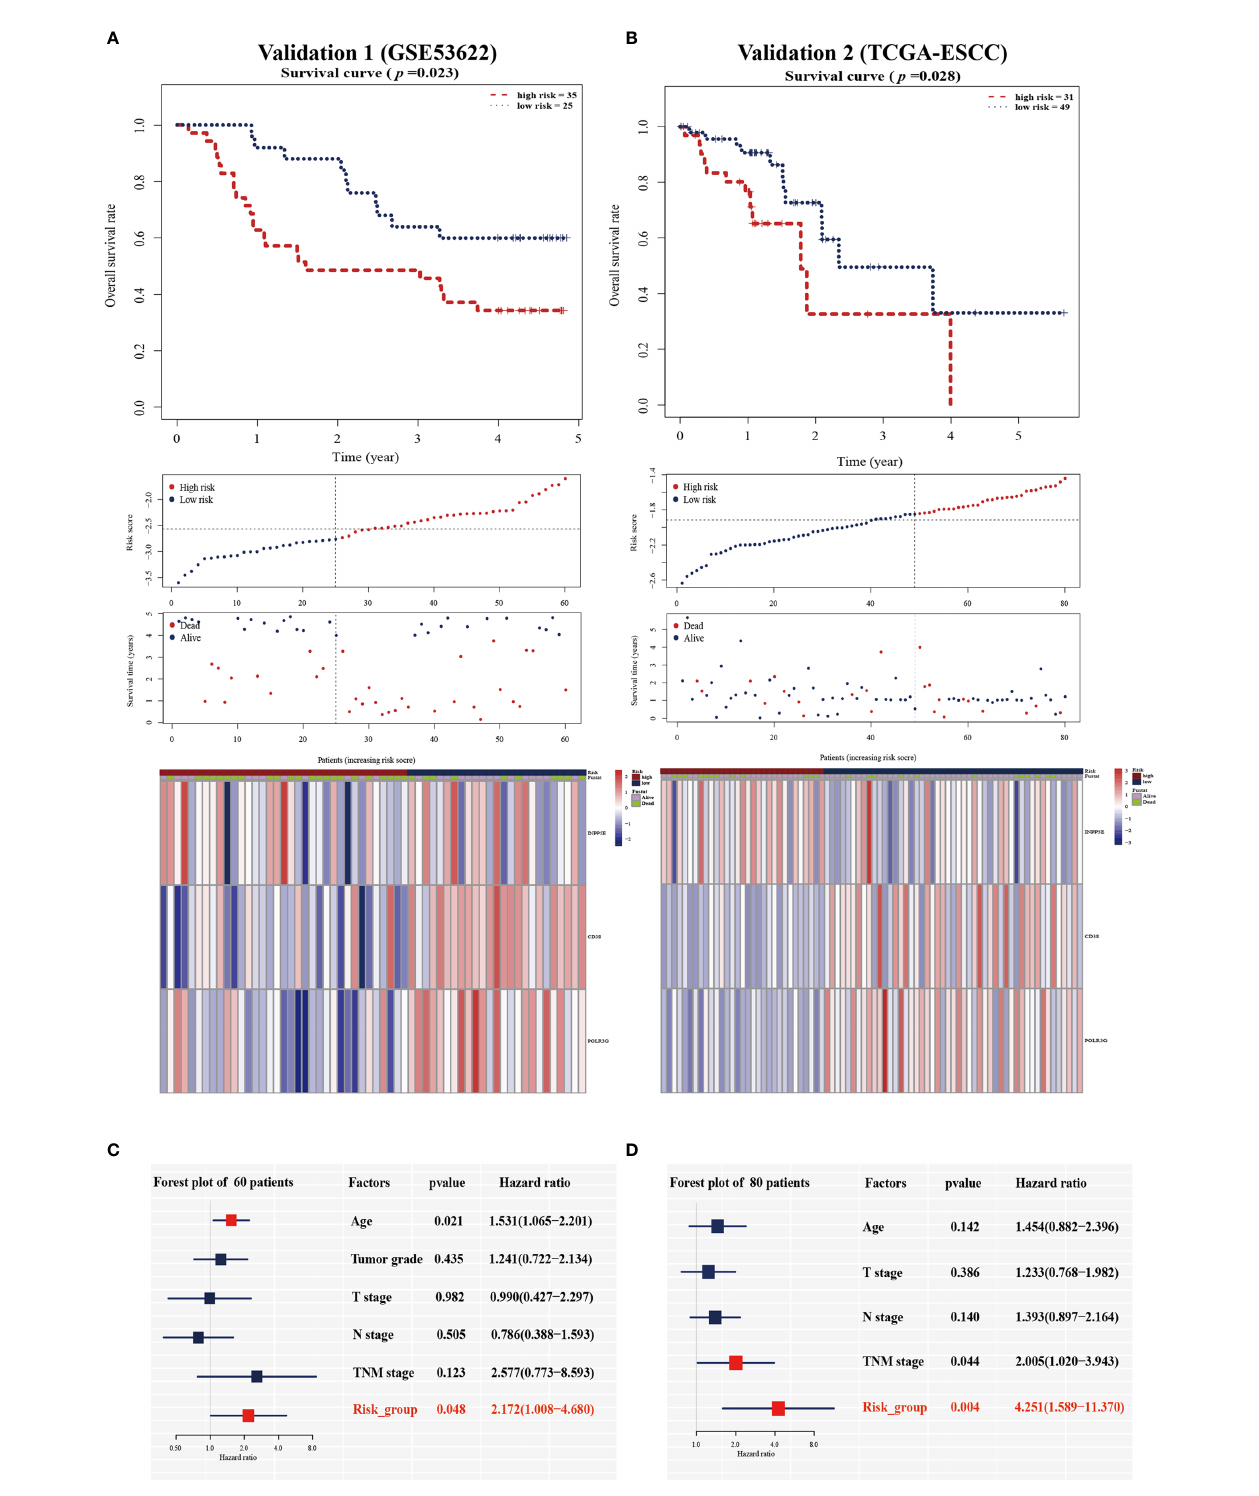
FIGURE 3 | Validation of the prognostic signature in the two validation cohorts. Kaplan-Meier survival analysis of overall survival, the distribution of patients ’ risk scores, survival status, and heatmap of the three gene signatures in the validation cohort of 60 patients (A) and 80 patients (B) . Multivariate Cox regression analysis in the two validation cohorts (C, D)